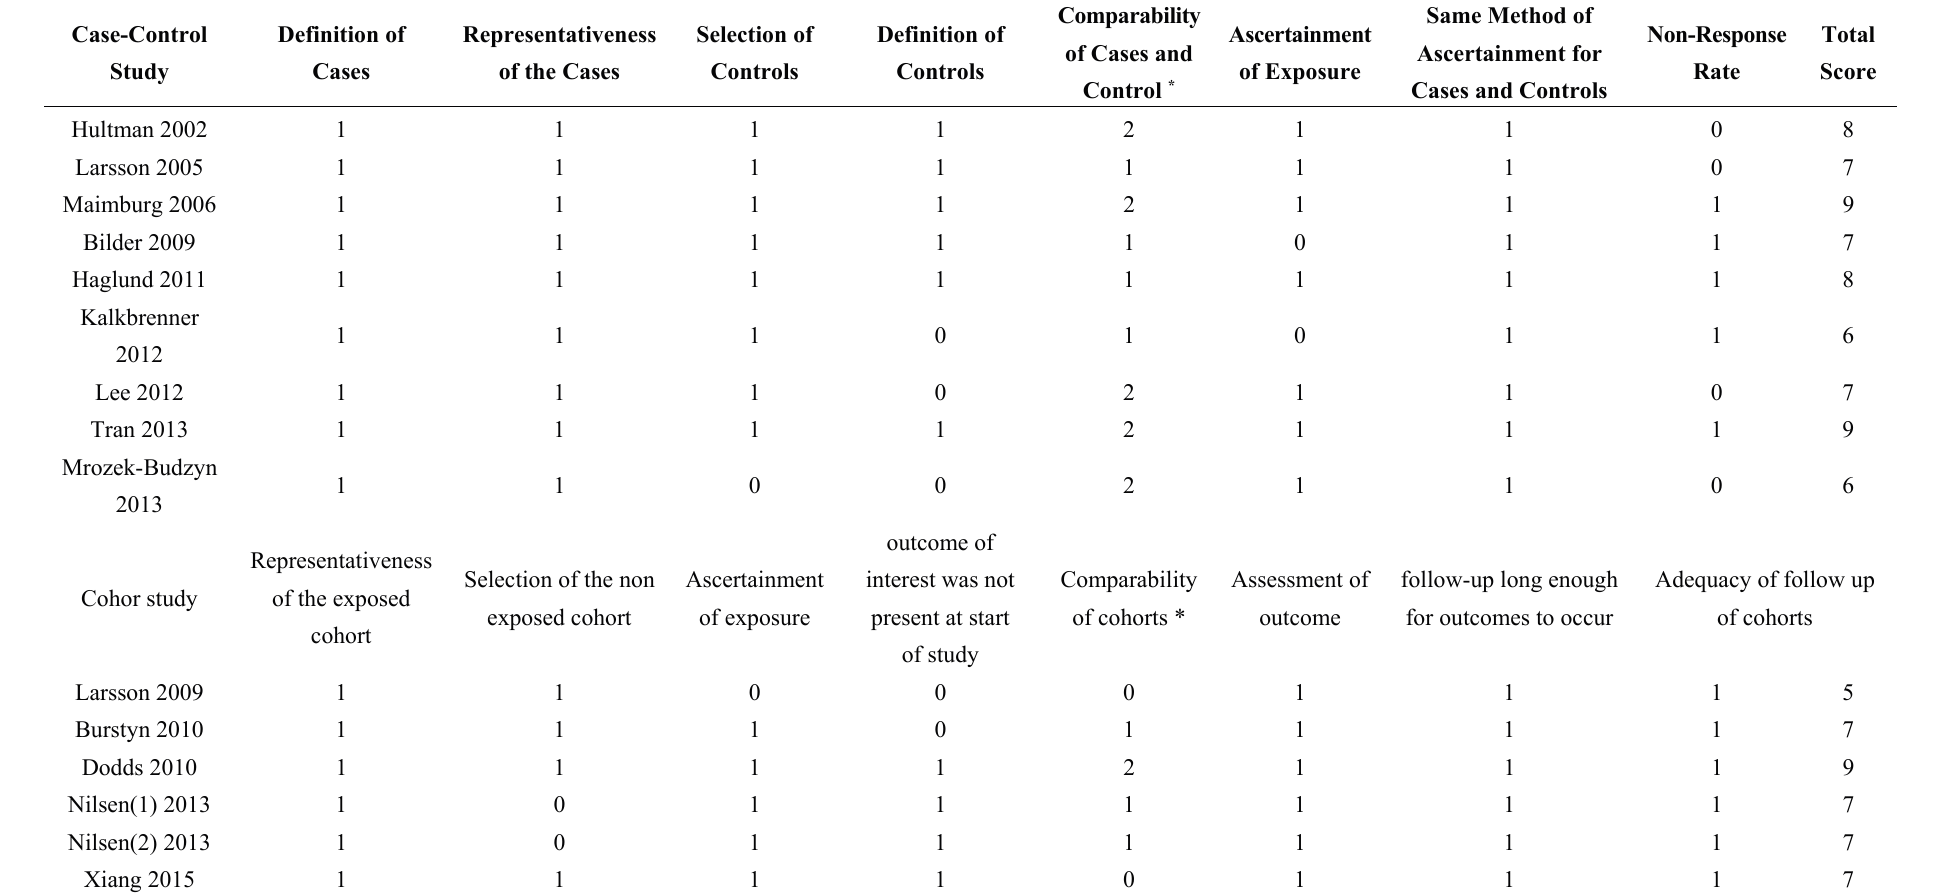
Supplemental Table 1. Quality assessment based on the Ottawa-Newcastle